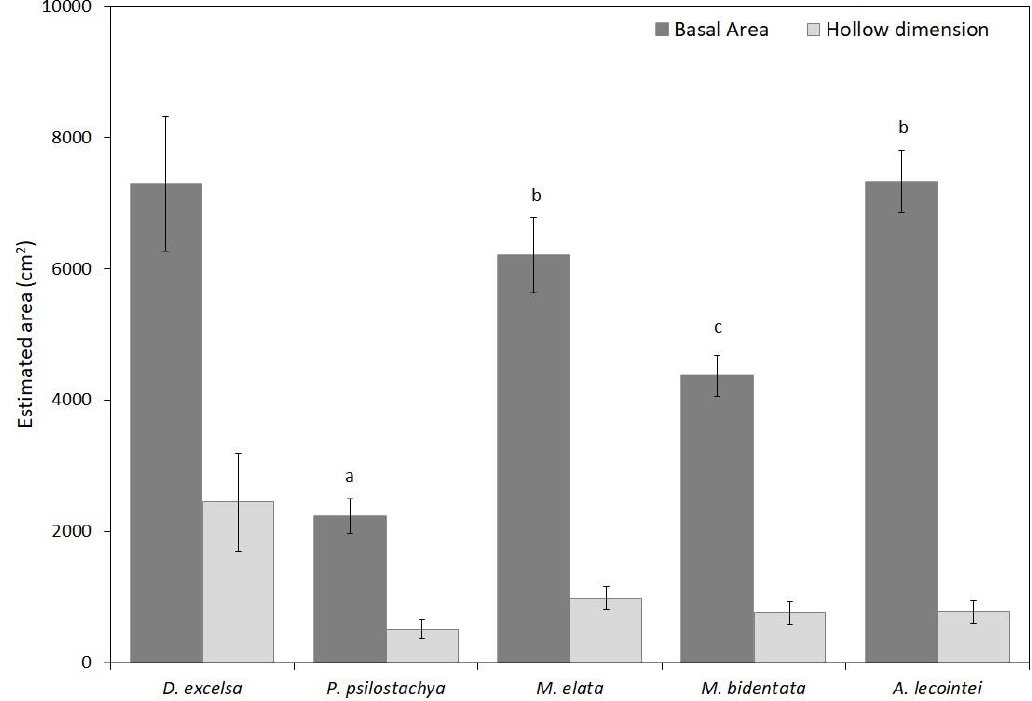
Figure 1. Tree stem basal area and area of stem hollows by tree species measured at 50 cm from the ground ( N = 8 for D. excelsa , N = 30 for P. psilostachya and M. elata , N = 28 for M. bidentata , and N = 20 for A. lecointei ). Letters indicate di ff erences at p < 0.05. Statistical comparisons included all species but D. excelsa . Table 2. Heartwood anatomical traits (mean ± SD) for the five tree species studied. Letters indicate di ff erences at p <